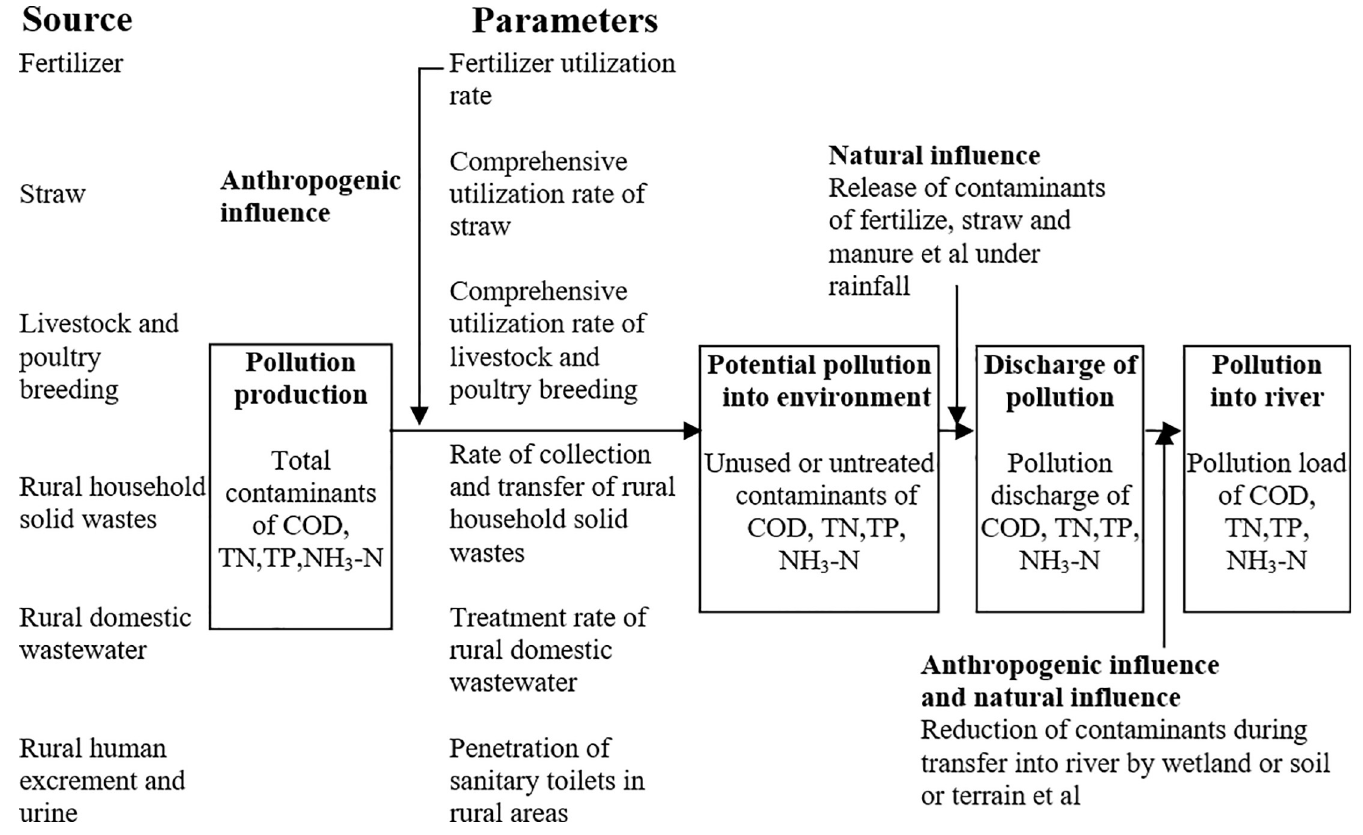
Fig 2. Flowchart summarizing the steps in a typical pollution calculation